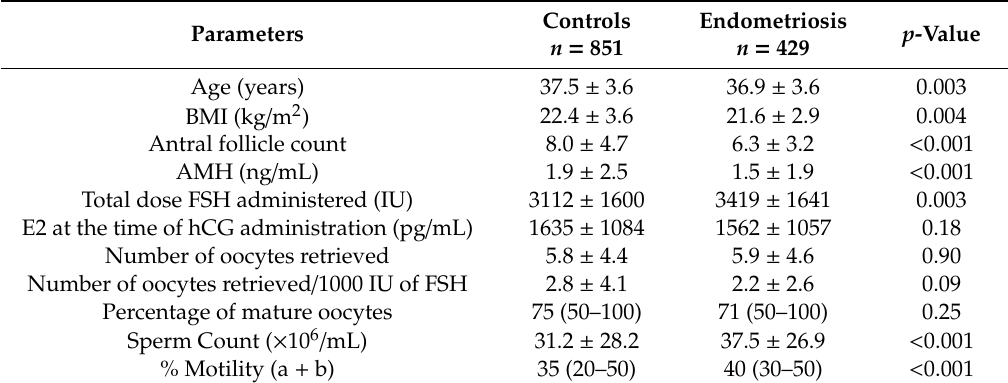
Table 1. Basal characteristics of the analyzed